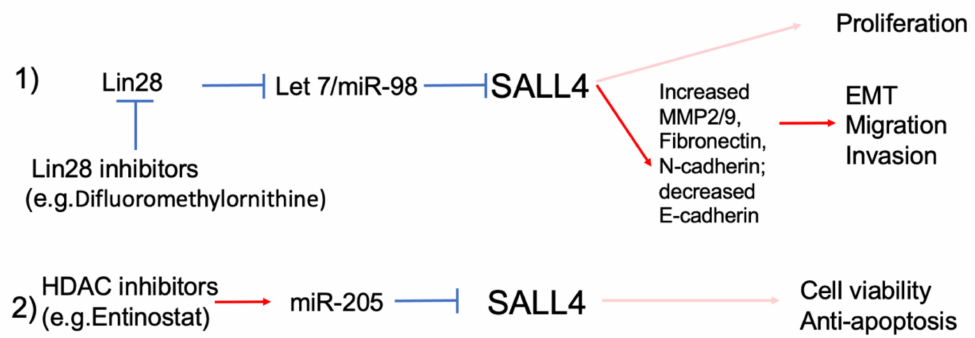
Figure 3. Strategies in targeting miR/SALL4 axis in cancer. We can inhibit SALL4 protein expression through miRs by (1) using LIN28 inhibitors to block its repression on Let 7/miR-98 which in turn decreases SALL4 expression (2) use of epigenetic drugs such as HDAC inhibitor Entinostat to upregulate miR-205, which in turn suppresses SALL4 expression. Solid lines represent experimentally validated epistatic